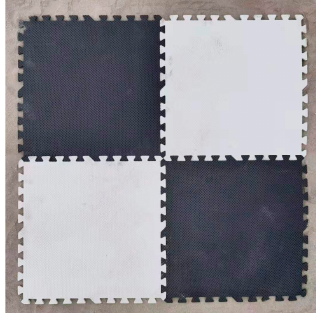
Figure 2. Ground control point.